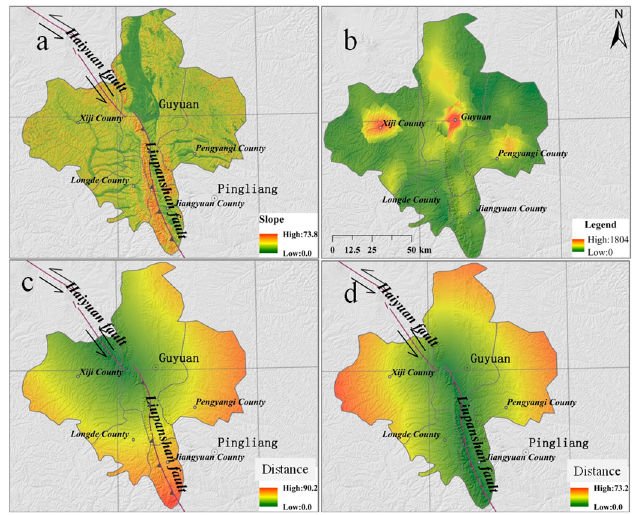
Figure 3. The slope, population density, and distance to faults; ( a ) the slope of the study area, ( b ) the population density of the study area, ( c ) the distance to the Haiyuan Fault, and ( d ) the distance to the Liupanshan Fault.